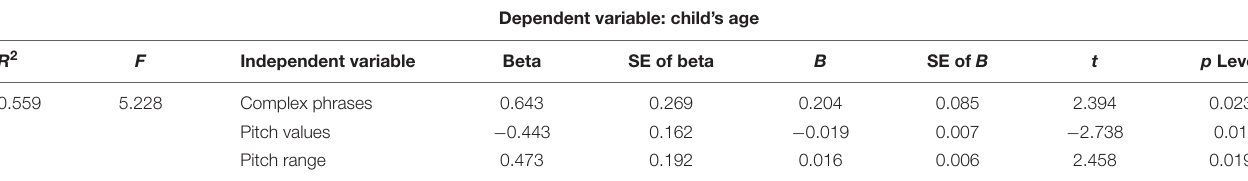
TABLE 6 | Result of multiple regression analysis: complex phrases frequency, pitch values, and pitch range/child’s age.